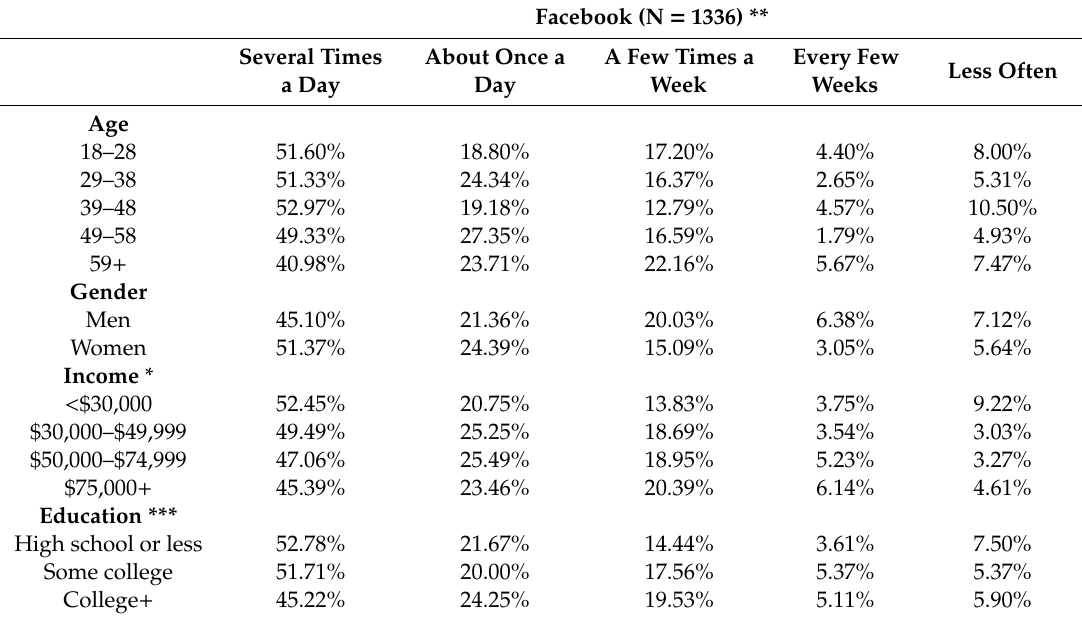
Table 5. Overview of Facebook users (own